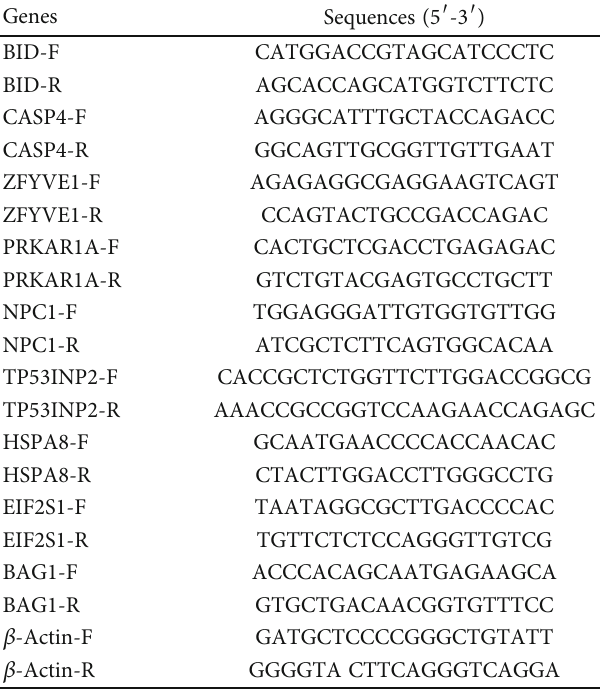
Table 1: Prime sequences. Genes Sequences (5 ′ -3 ′